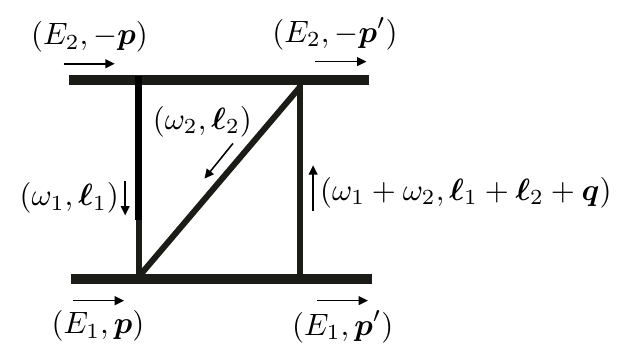
Figure 19 . The double-triangle prime